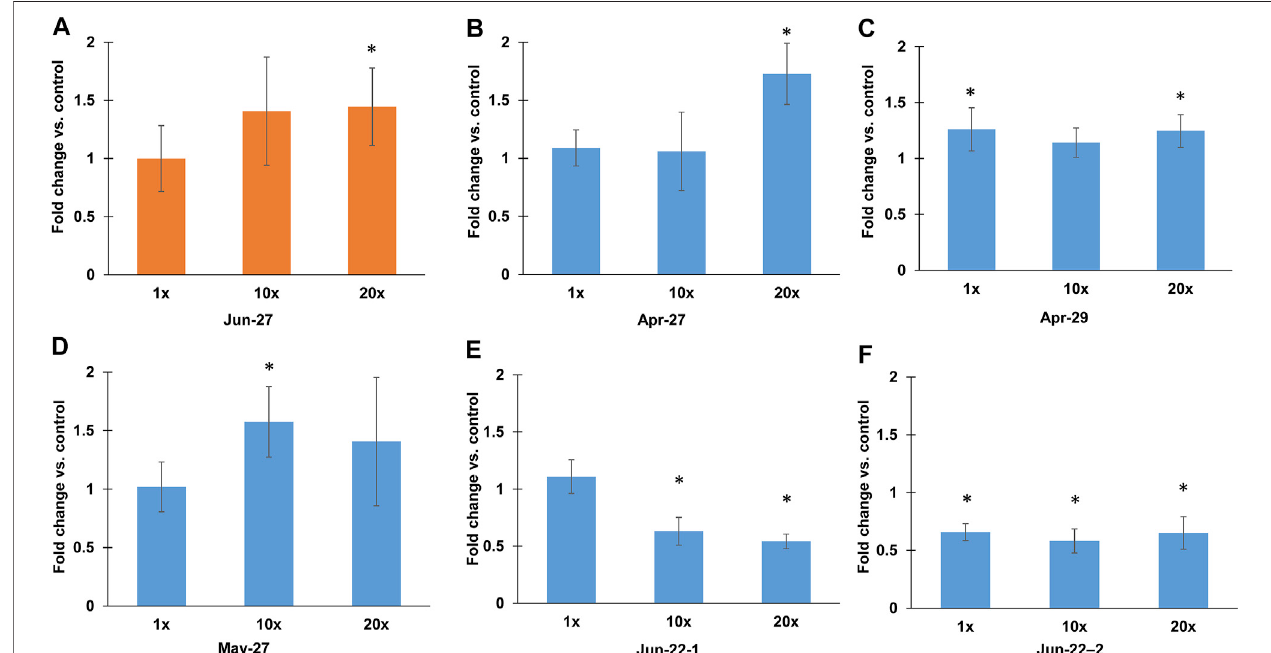
FIGURE3| Foldchangesofnumberof Salmonella Typhimuriumrevertantscomparedtothenegativecontrol. (A) Foldchangesof S. TyphimuriumTA98at×1,×10 and ×20 concentration of 27 June sample (B – F) Fold changes of S. Typhimurium TA100 at ×1, ×10 and ×20 concentration of (B) 27 April sample, (C) 29 April sample, (D) 27 May sample, (E) 22 June sample replicate 1, (F) 22 June sample replicate 2. Asterisks denote signi fi cant difference compared to negative